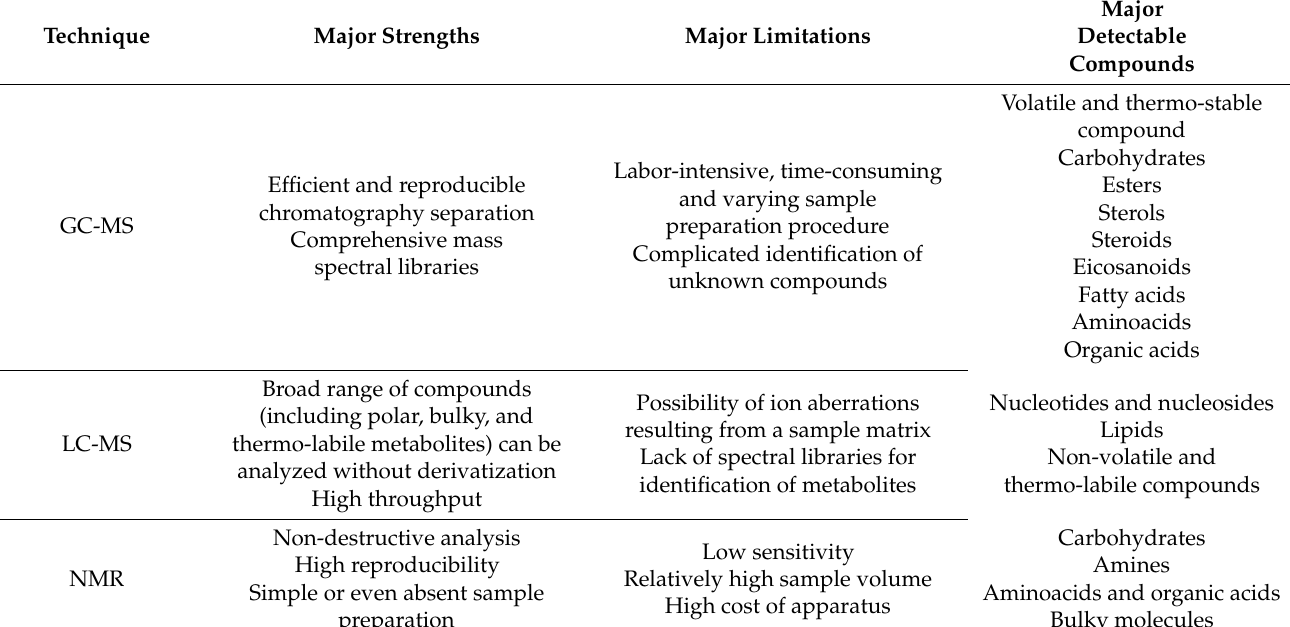
Table 1. Major characteristics of NMR, GC-MS, and LC-MS techniques used in metabolomics.